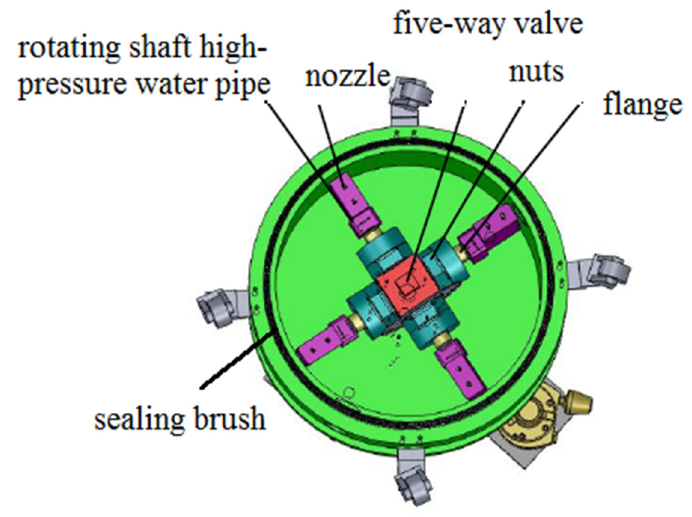
Figure 3. Internal structure of the coating removal device.